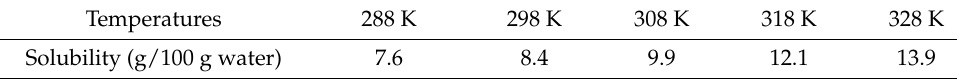
Figure 9. Removal of sodium at different temperatures through the modified Solvay process. Table 4. Solubility of sodium bicarbonate at different temperatures.